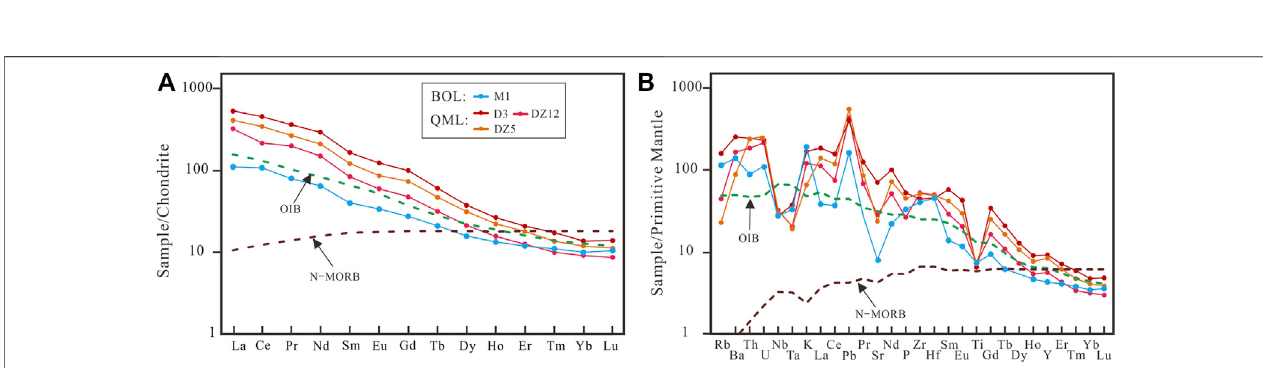
FIGURE 5 | (A) chondrite-normalized REE pattern and (B) primitive mantle-normalized spider-diagram of the lamprophyres in the Tuquan Basin. Data sources: chondrite (Sun and McDonough, 1989), primitive mantle (Sun and McDonough, 1989), N-MORB, and OIB (Sun and McDonough, 1989).